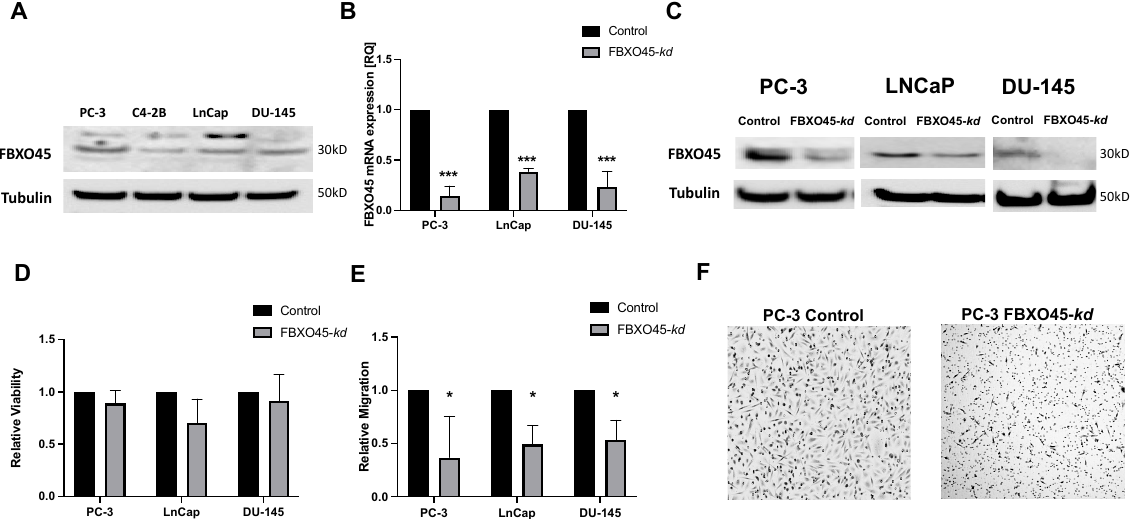
Figure 3. Functional impact of FBXO45 loss in prostate cancer cell culture models. ( A ) Baseline FBXO45 protein expression in different prostate cancer cell lines. ( B ) FBXO45 mRNA ( B ) and protein